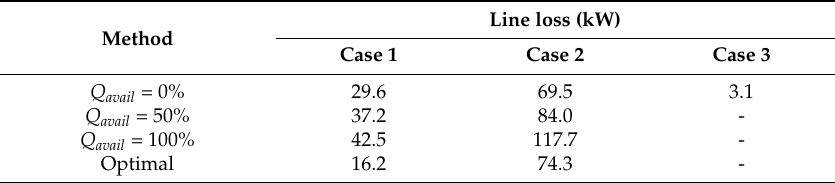
Table 4. Total line losses for each